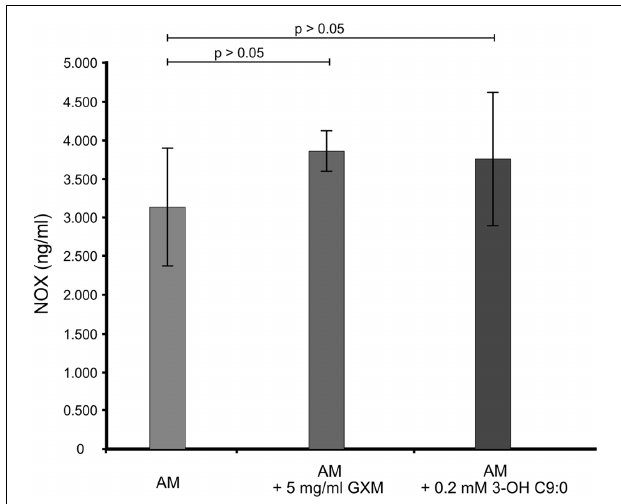
FIGURE 2 | The ELISA quantitative results showing the levels of NADPH oxidase-1 (NOX) present across the different experimental conditions i.e., GXM-treated amoeba (AM) and 3-OH C9:0-treated amoeba, including the control i.e., non-treated amoeba cells. There was no significant ( p > 0.05) difference between the control results and the experimental